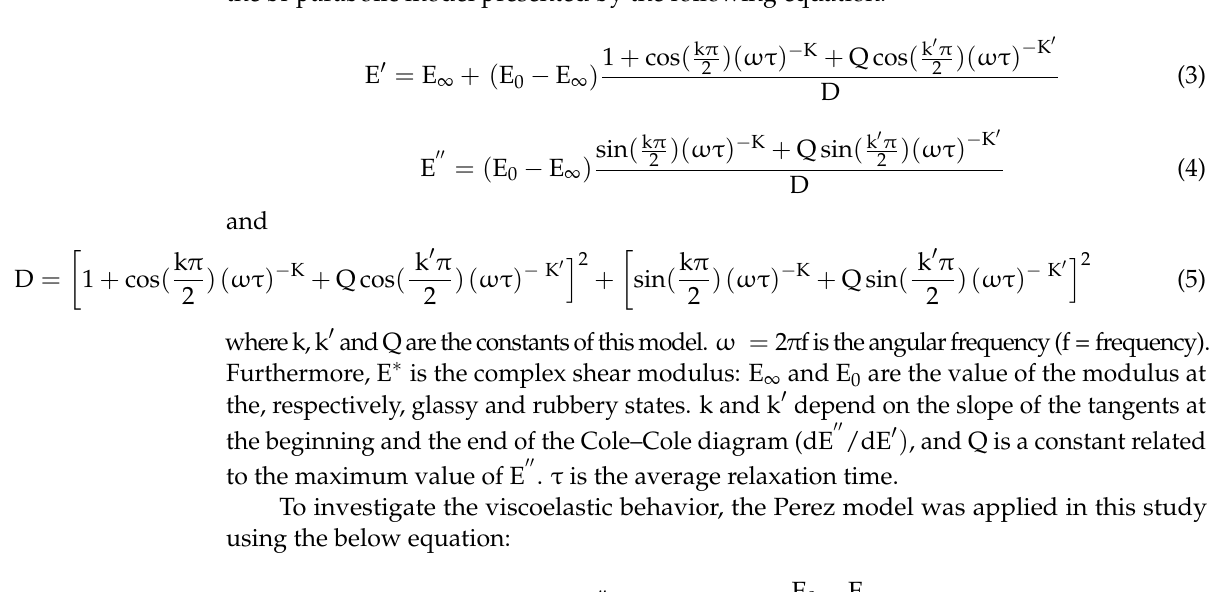
Figure 10. Cole–Cole plot of polyurethane ( a ) PU-Pure, ( b ) PU-10% and ( c ) PU-20% of drug at different times of release at the flow rate of 7.5 mL/s (f = 1 Hz).